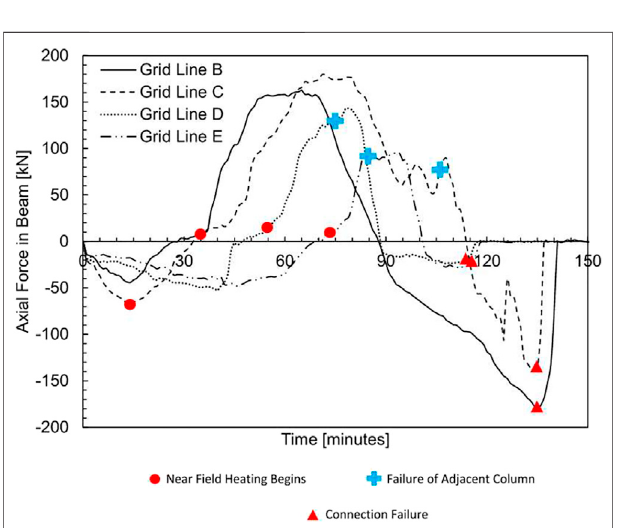
FIGURE 17 | Axial force histories of secondary beams spanning between MRF and gravity columns in Fire Scenario #3.